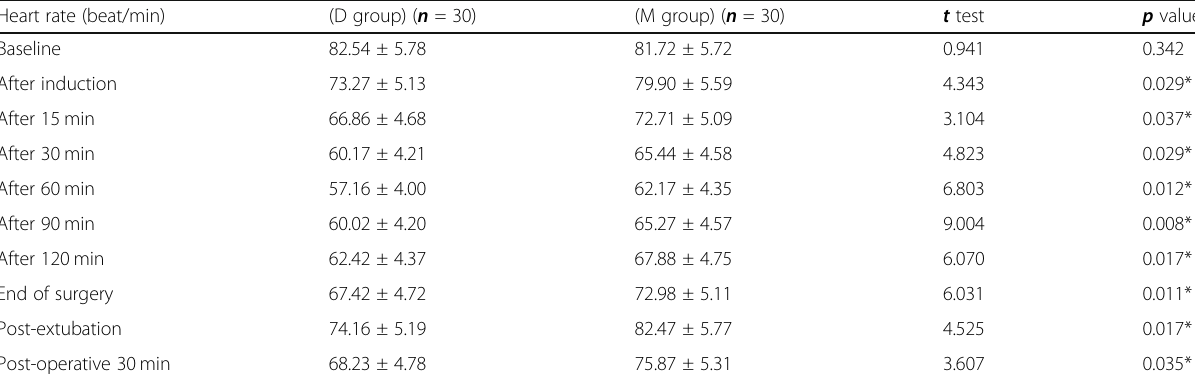
Table 5 Comparison between both groups regarding the heart rate (beat/min) Heart rate (beat/min) (D group) ( n = 30)